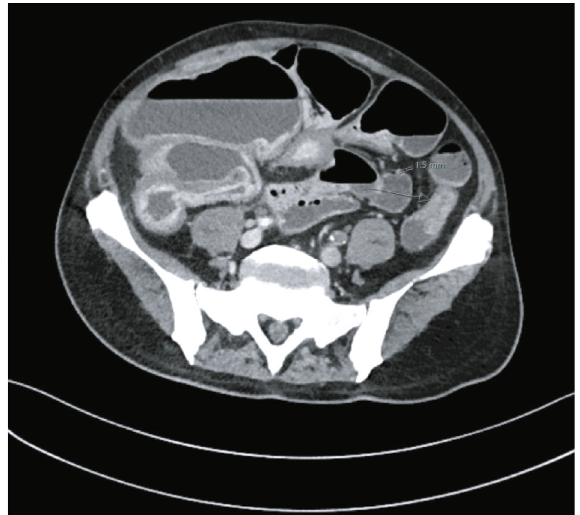
Figure 1: Abdominal CT scan taken at the L5 level, demonstrating focal mucosal thickening and dilation of the ascending and proximal descending colon.